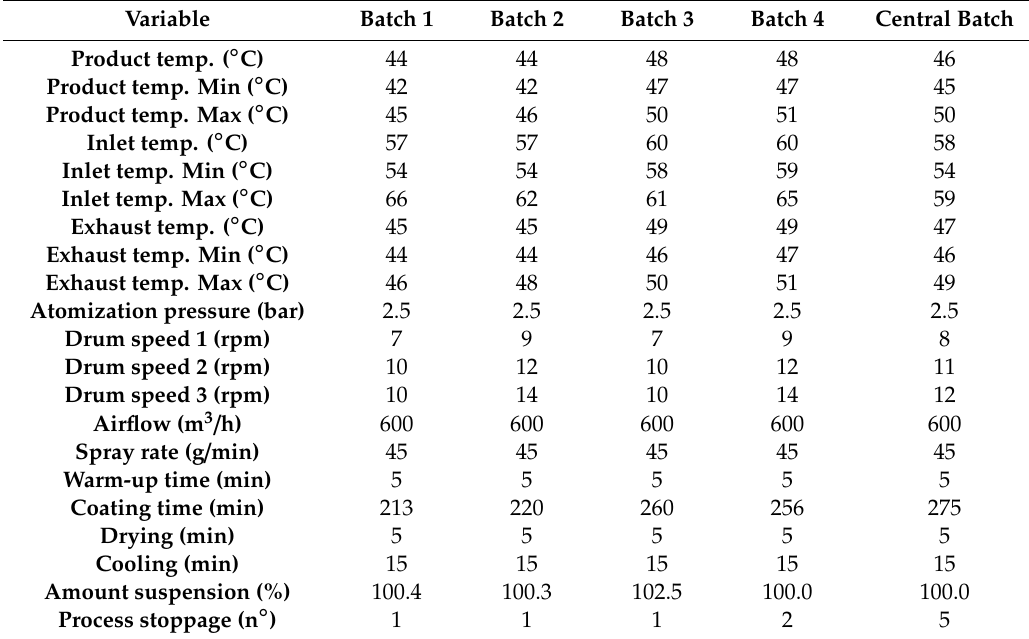
Table 3. Average values per process parameter in each manufactured batch. The process parameters to be optimized are marked in the table.